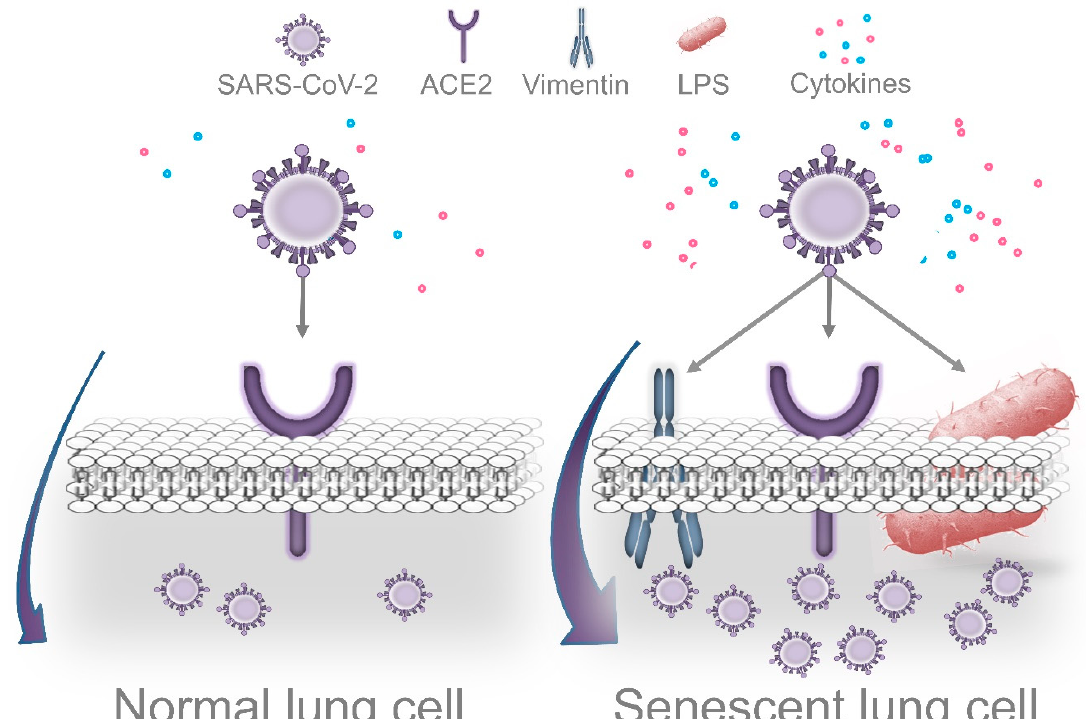
Figure 3. Dissemination of periodontal bacteria into lung tissues may cause Lipopolysaccharide-induced senescence, which facilitates SARS-CoV-2 cell attachment, entry, and replication. Accumulation of senescent cells in lungs is a normal event during the process of aging. Recently, it was demonstrated that cells that survive P. gingivalis infection display features of accelerated aging. Thus, periodontal bacteria that colonize lung tissues could aggravate age-related accumulation of senescent cells, which may facilitate more efficient viral replication. Several morphological and functional features of senescent cells could promote this process. In agreement with this concept, the senescence-associated cytoskeletal protein vimentin acts as a coreceptor of coronaviruses’ spike protein, promoting cell binding and entry. Intriguingly, SARS-CoV-2 causes DNA damage, cell growth arrest, cytokine production, and p38 activation during the early stages of infection as a strategy to promote more efficient replication. These are prominent features of cellular senescence. On the other hand, LPS interacts with the SARS-CoV-2 spike protein, which potentiates the inflammatory reaction produced by low concentrations of LPS alone.